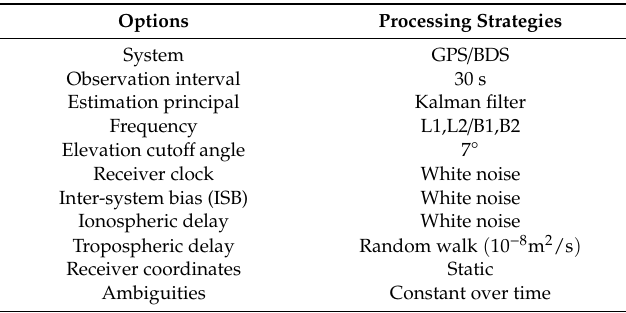
Table 1. Adopted models and